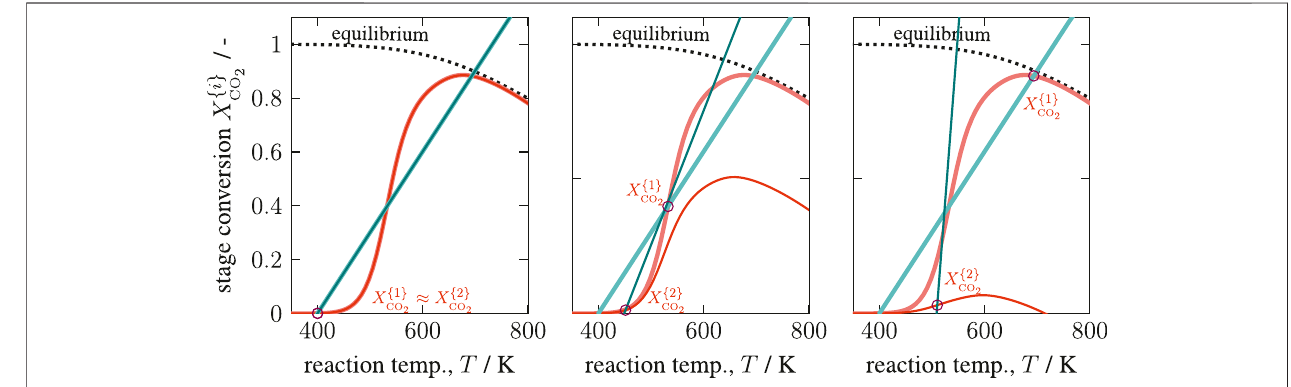
FIGURE 7 | Graphical solution of a two-stage CSTR series with state combination [1-1], [2 – 1], and [3 – 1], reference setting taken from Supplementary Table S1 but T { 1 } op (cid:2) 400 K and T in (cid:2) T cool